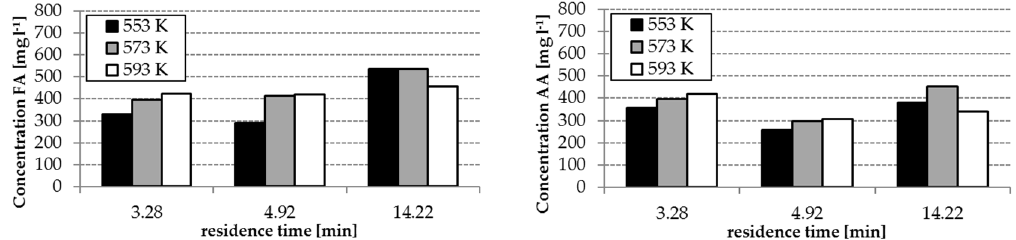
Figure 4. Concentrations of FA and AA after hydrothermal treatment of grass suspensions with catalyst (CTR, 1 % w / w grass powder and 5% w / w K2CO3 suspended in water; residence time: 3.28–14.22 min, reaction temperature: 553–593 K).